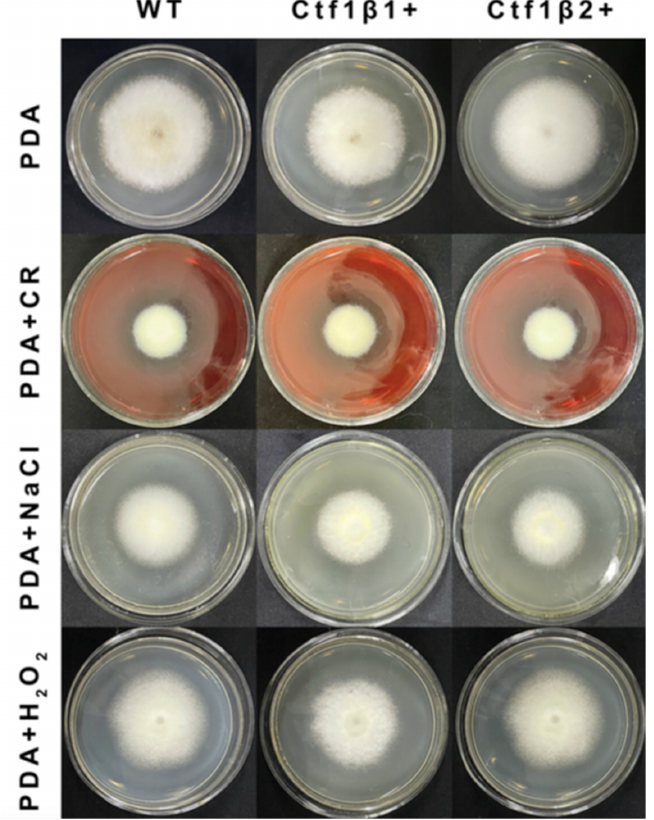
Figure 15. Comparison of phenotypic tolerance of the wild-type, Ctf1 β 1 complemented strain and Ctf1 β 2 complemented strain. Note: Wild-type, Ctf1 β 1 complemented strain and Ctf1 β 2 comple- mented strain were inoculated on PDA media or PDA media appended with various stressors and cultured at 25 °C in darkness for 5 days.